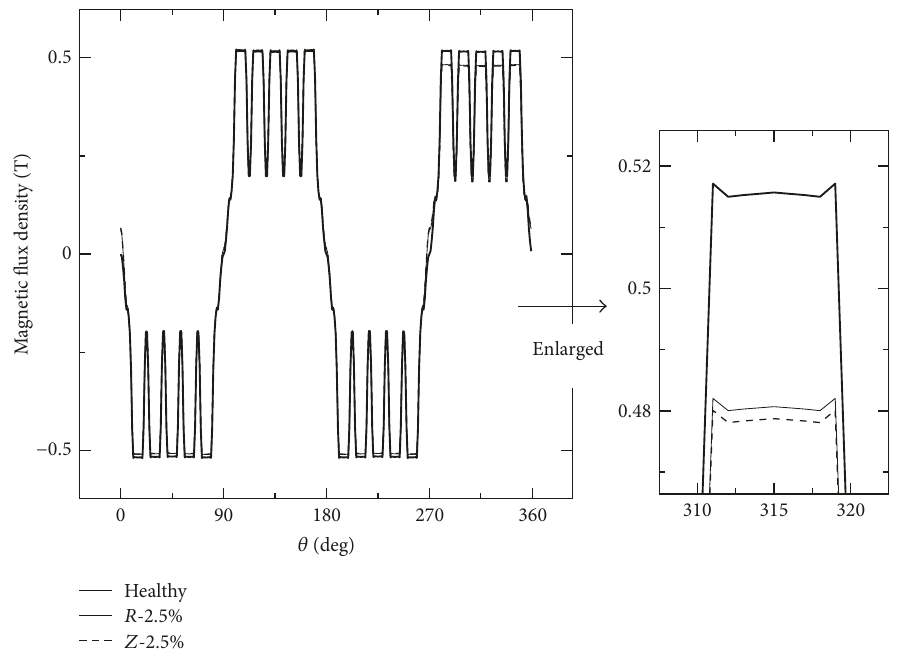
Figure 7: Calculated magnetic flux density at the center of the air-gap and axial location ( 𝑧 = 0).